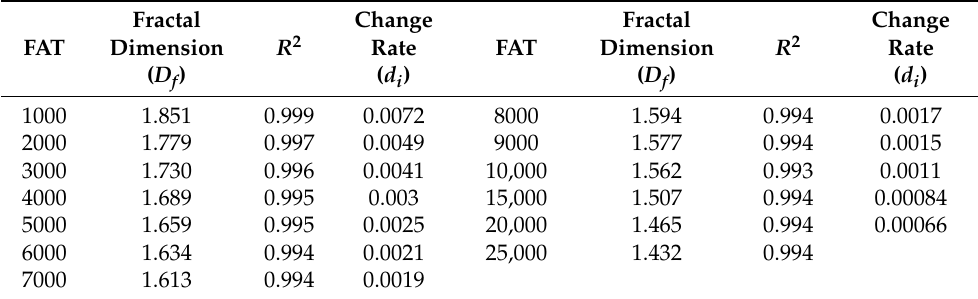
Table 6. Fractal parameters obtained with the box-counting method (Hubei Province).